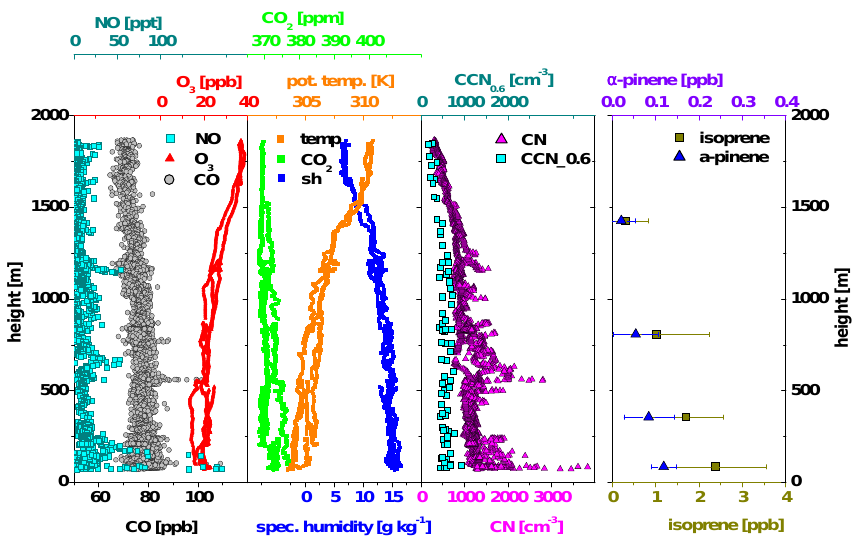
Fig. 3. Background concentrations of trace constituents and meteorological data measured during Flight #18 on 19 July 10:00–14:00 LT. All data collected outside of the plume (i.e., at either side of each transect of the 18 transects, during ascending or descending to the next flight altitude) were merged. As there were no background VOC measurements within this specific flight, the mean vertical profiles of isoprene and α -pinene from 8 background flights during the LBA-CLAIRE-2001 campaign are shown in the right panel (see Kuhn et al., 2007).